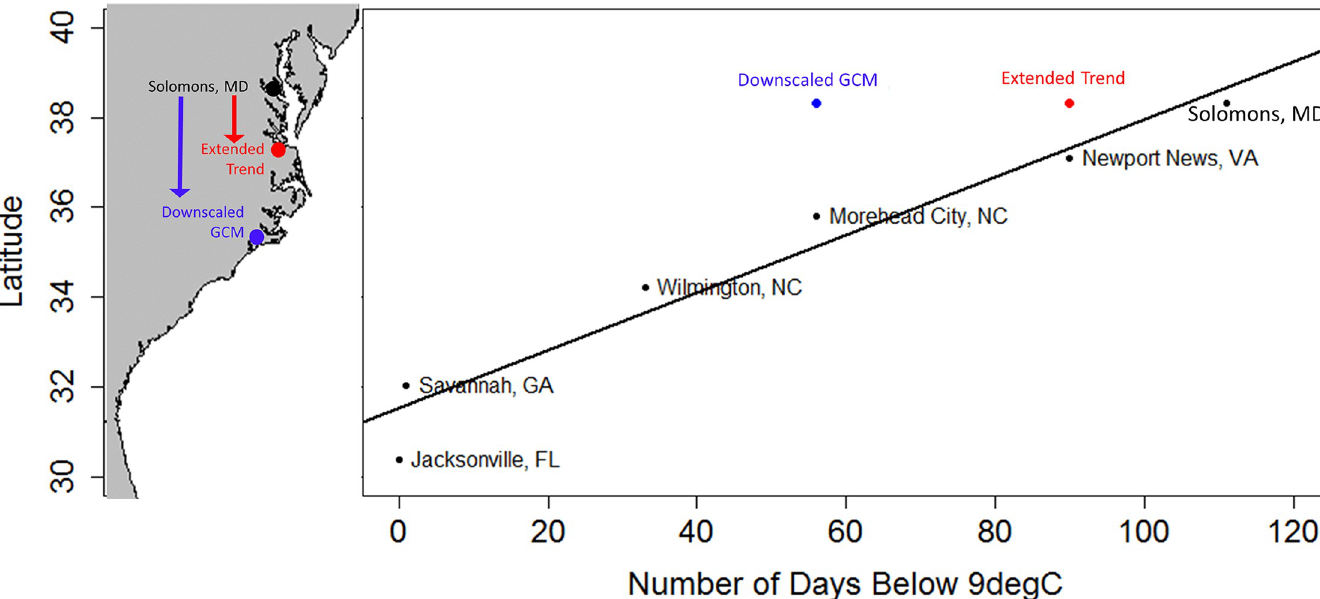
Fig 4. Number of days below 9˚C by latitude at different locations along the east coast of the US from 2012–2016. Points in black indicate observational data from the CBL Pier and the National Data Buoy Center. The black line is the linear regression of the observations with latitude. The red and blue points indicate the location equivalent to number of days below 9˚C projected by the extended trend and the multi-model ensemble of downscaled GCM data, respectively. Direct extension of trend in the observational data predicted a shortening of the overwintering period from 117 ± 15 days to 90 ± 1 days and the downscaled GCM model data predicted a shortening of the current overwintering period to 56 ± 15